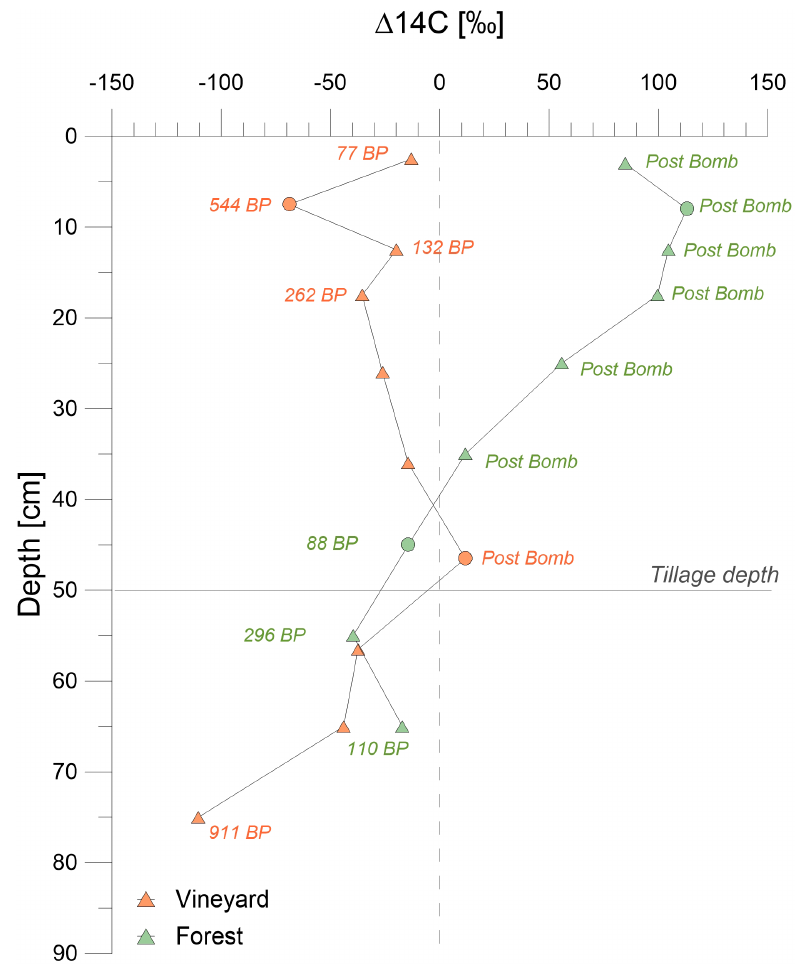
Figure D1. Comparison of the BP age patterns, via (cid:49) 14 C (‰), as a function of the soil depth and vegetation cover.